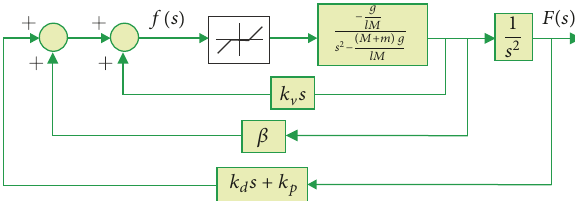
Figure 4: Closed-loop system considering a dead-zone nonlinear- ity.